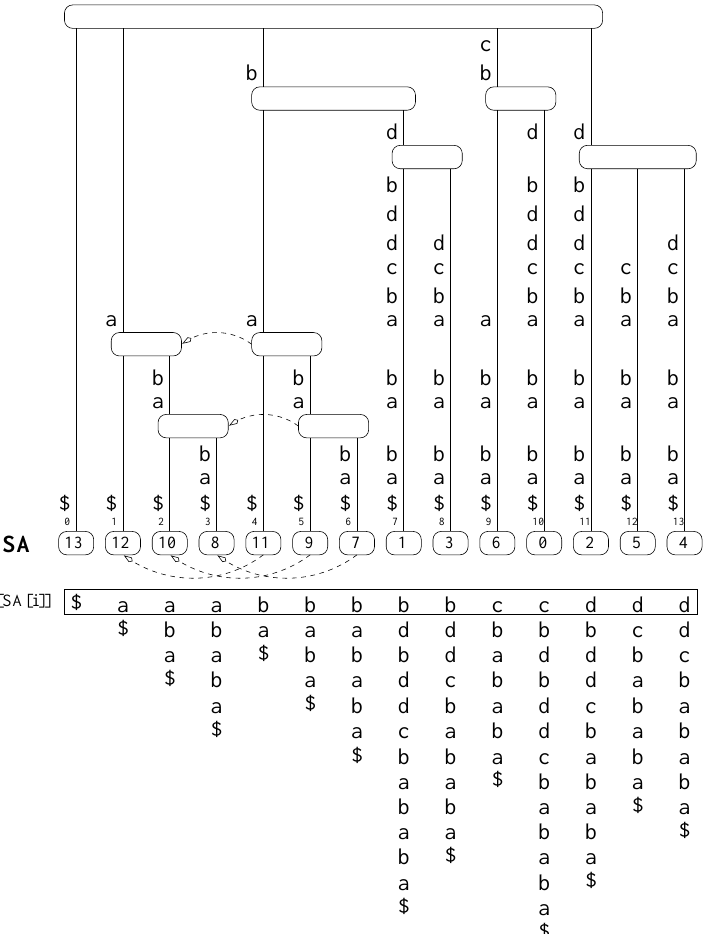
Figure 1. On top, suffix tree for cbdbddcbababa $ . Some suffix links are shown (dashed arrows). On the bottom, suffix array of T